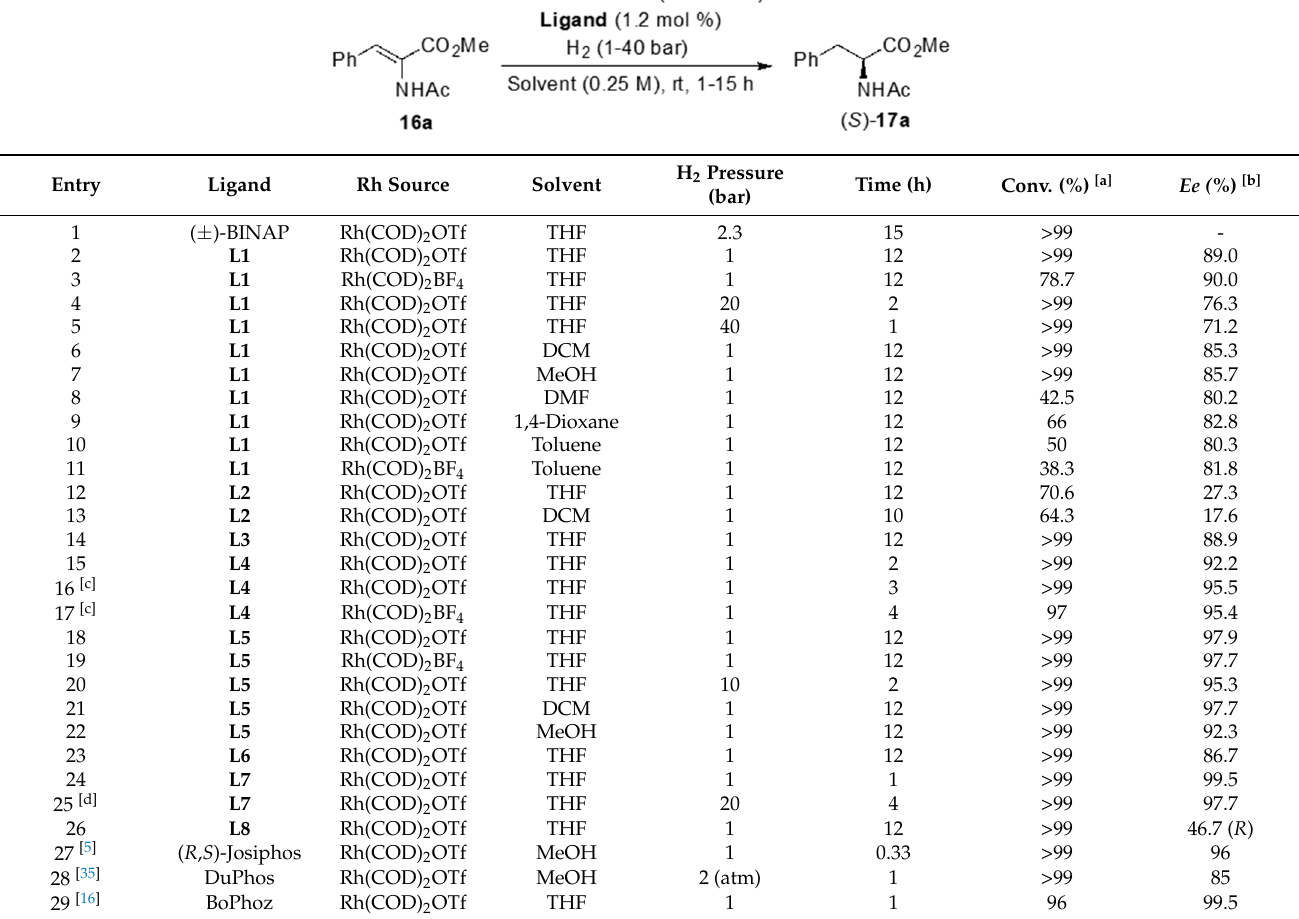
Table 2. Screening of asymmetric hydrogenation conditions with substrate 16a .